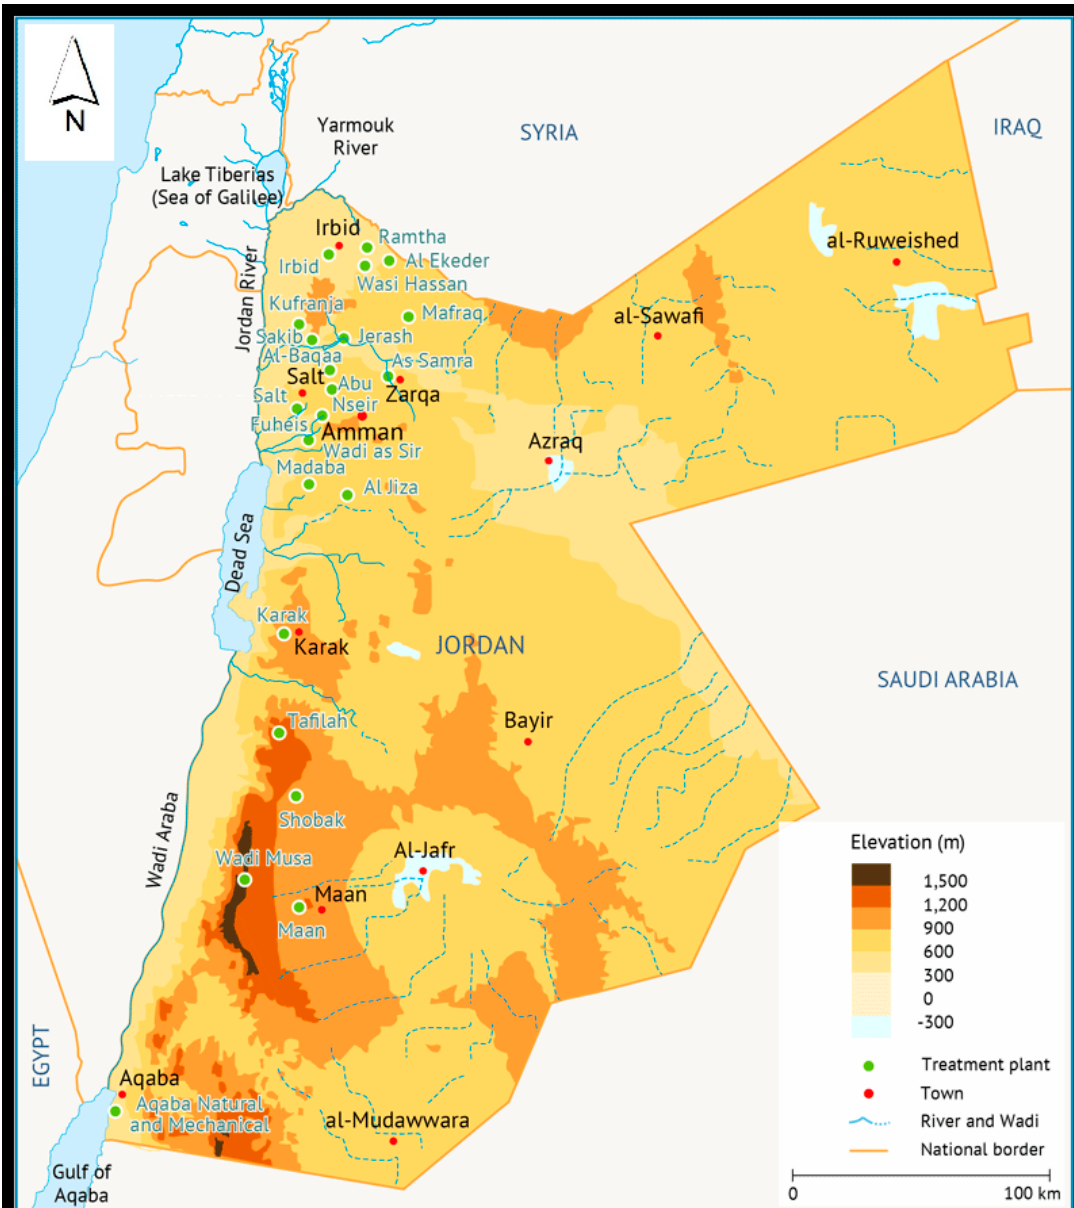
Figure 1. Water resources in Jordan.